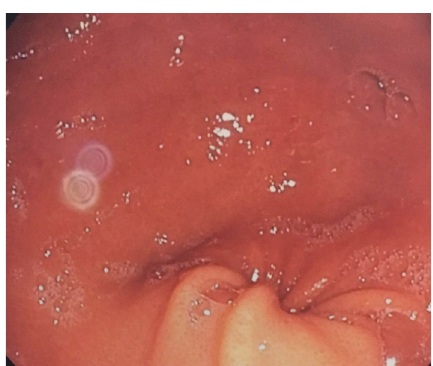
Figure 2: Congestive